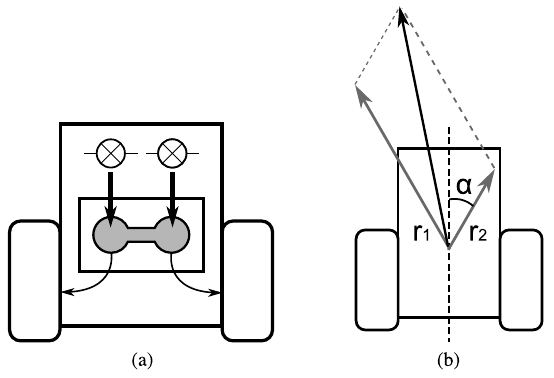
Fig. 7. Trajectory of the simulated vehicle driven by experimental data. α = π/ 720 is used in this simulation. The vehicle started from (0,0). Black line indicates the period when there is no light illu- mination to wells, and red line is when a right well is illuminated by light. (Colours are visible in the online version of the article;